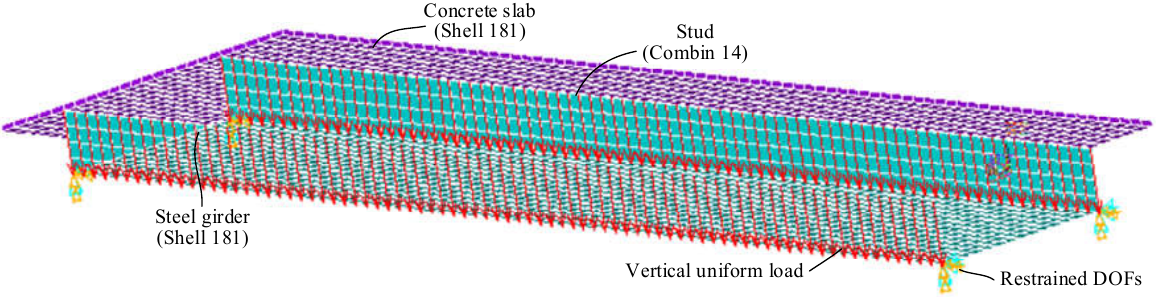
Figure 5. Finite elaborate element model of a simply supported composite bridge.